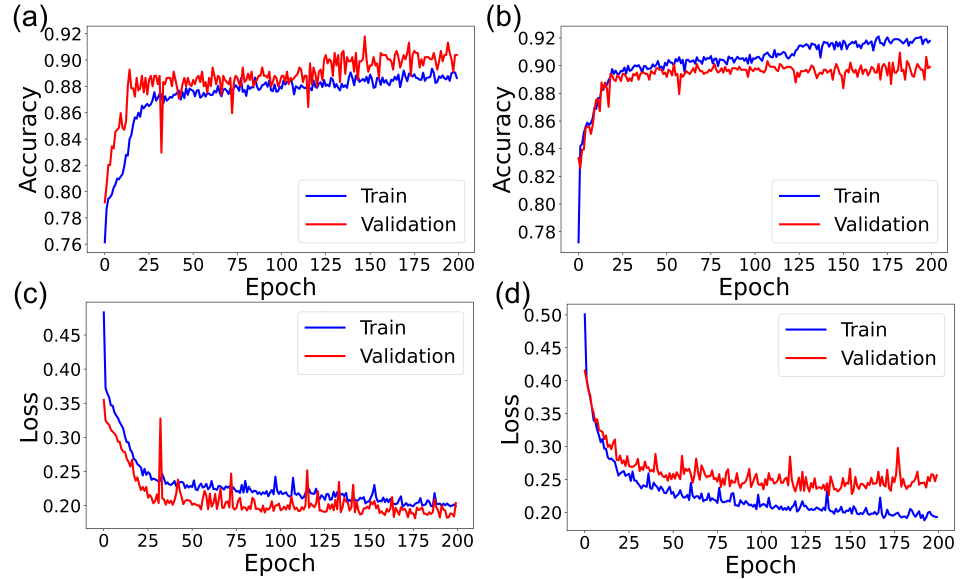
Figure 7. Accuracy and loss curves for SF in tubes with EDTA. ANN with 2 hidden layers and 200 epochs. ( a ) Accuracy for unbalanced data. ( b ) Accuracy for balanced data. ( c ) Loss for unbalanced data. ( d ) Loss for balanced data.